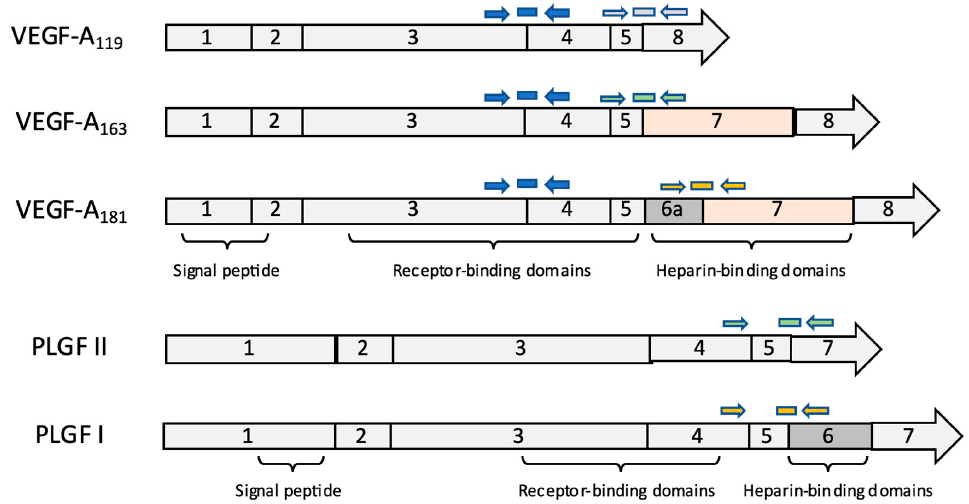
Figure 2. VEGF-A and PLGF isoforms. VEGF-A and PLGF occur in multiple protein isoforms, encoded by alternatively spliced pre-mRNAs that differ in their biochemical and biological characteristics. VEGF-A and PLGF exons 1–5 are present in all isoforms and code for the signal peptide and receptor-binding domains; splice variants exclude sequences encoding heparin-binding domains. The common and isoform-specific sites targeted by qRT-PCR are indicated by the arrows and bars, representing primers and fluorogenic probes, respectively.